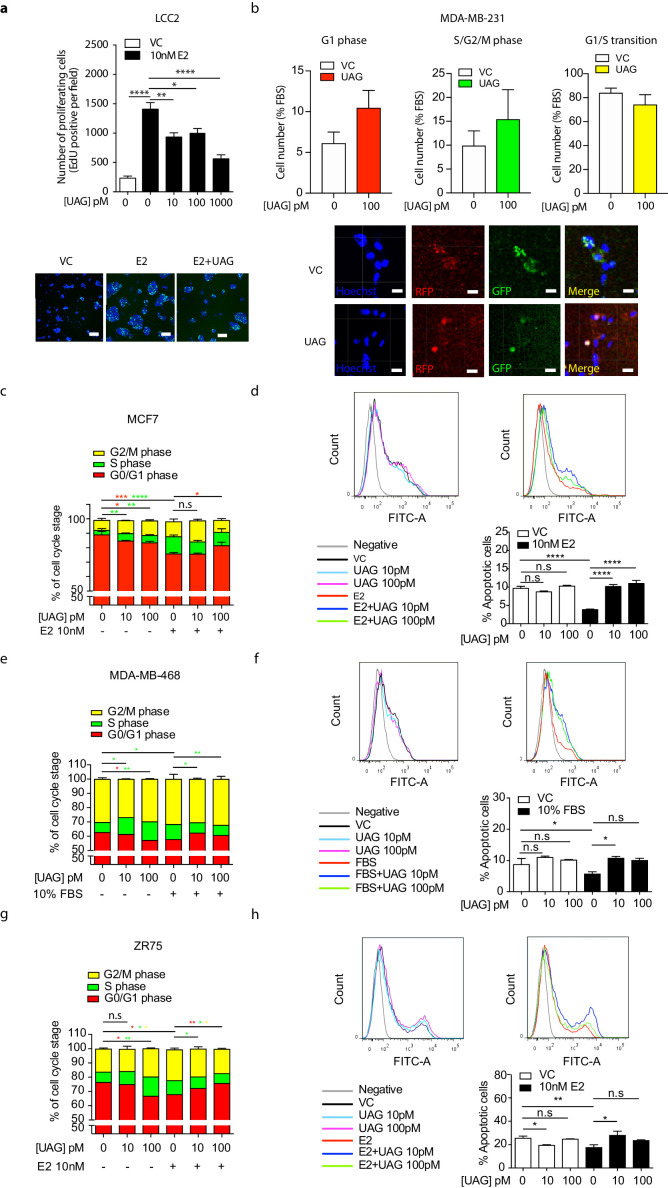
Unacylated ghrelin causes cell cycle arrest and apoptosis.(a) Unacylated ghrelin (UAG) significantly inhibits the proliferation of tamoxifen-resistant LCC2 cells in the presence of estradiol (10 nM). Representative images showing EdU incorporation (green). Hoechst nuclear stain (blue). Scale bar represents 100 μm. (b) No effect of UAG on cell cycle was observed in MDA-MB-231 cell using FUCCI cell cycle system. Flow cytometry analysis demonstrating that UAG induces G1-phase cell cycle arrest and apoptosis in (c, d) MCF7, (e, f) MDA-MB-468 and (g, h) ZR75 cells. Data represent mean ± SEM with three replicates/group. Experiments were repeated at least twice. UAG: unacylated ghrelin; FBS: fetal bovine serum; E2: estradiol.Figure 4—figure supplement 1—source data 1.Unacylated ghrelin causes cell cycle arrest and apoptosis.